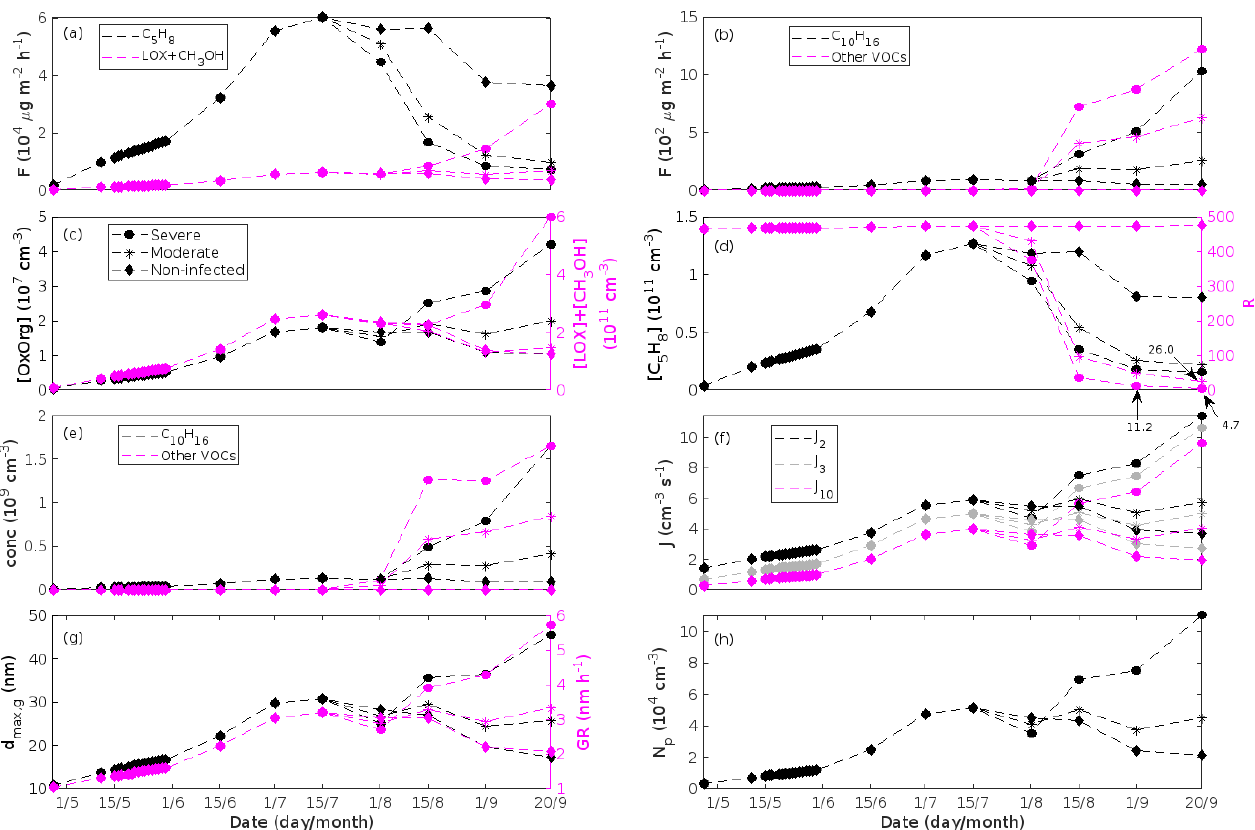
Figure 8. A pure poplar stand infected by rust fungi in comparison to a non-infected pure poplar stand. Canopy emissions of (a) isoprene and the sum of lipoxygenase pathway volatiles and methanol and (b) monoterpenes and the sum of other VOCs that contribute to OxOrg formation (i.e. methyl salicylate, dimethyl-nonatriene, α -Eudesmol, and sesquiterpenes). Atmospheric concentrations of ( c , left axis) OxOrg, ( c , right axis) the sum of lipoxygenase pathway volatiles and methanol, ( d , left axis) isoprene, and (e) monoterpenes and the sum of other VOCs that contribute to OxOrg formation. ( d , right axis) The ratios of isoprene-to-monoterpene carbon concentrations. (f) Formation rates of 2, 3, and 10nm particles. ( g , left axis) Daily maxima diameter of the growing particle mode and ( g , right axis) growth rates of newly formed particles. (h) Number concentrations of formed particles. “Moderately” and “severely” refer to 30% and 80%, respectively, of the leaf area that has been infected by fungi by the onset of